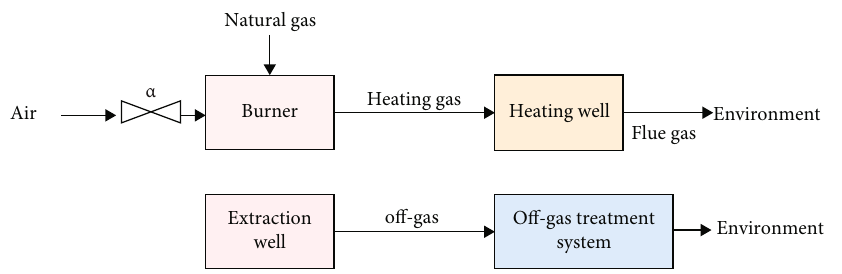
Figure 1: Flow diagram of gas in BM